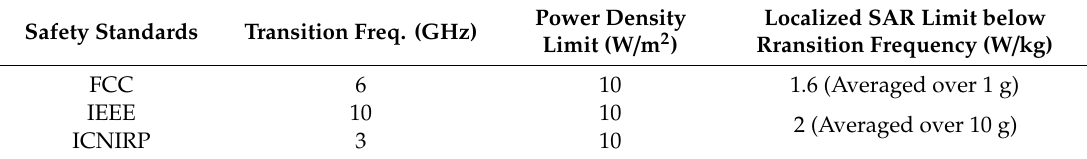
Table 3. Public Safety Limitations for Electromagnetic